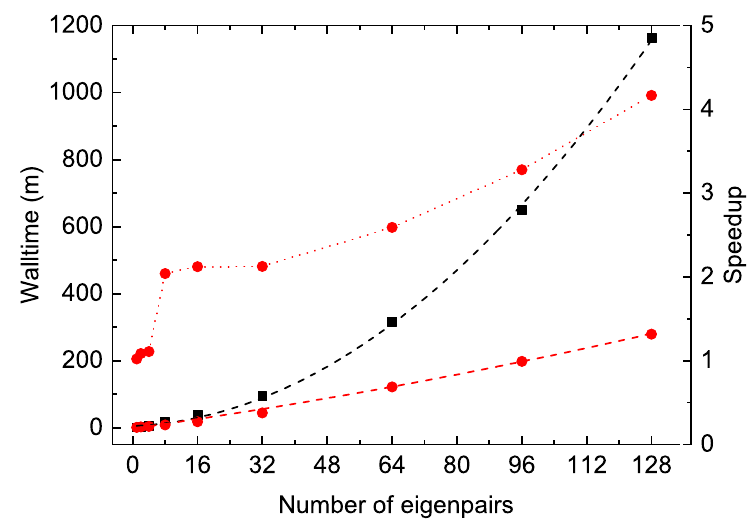
Figure 9. CPU times (in min) for searching different numbers of eigenpairs of the 2 + block in Mg VII. Dashed lines: CPU times for rci_mpi (squares) and rci_mpi_CSFG (circles). The lines are reproduced by a quadratic polynomial fit. Dotted line (right y axis): speed-up factors of rci_mpi_CSFG relative to rci_mpi